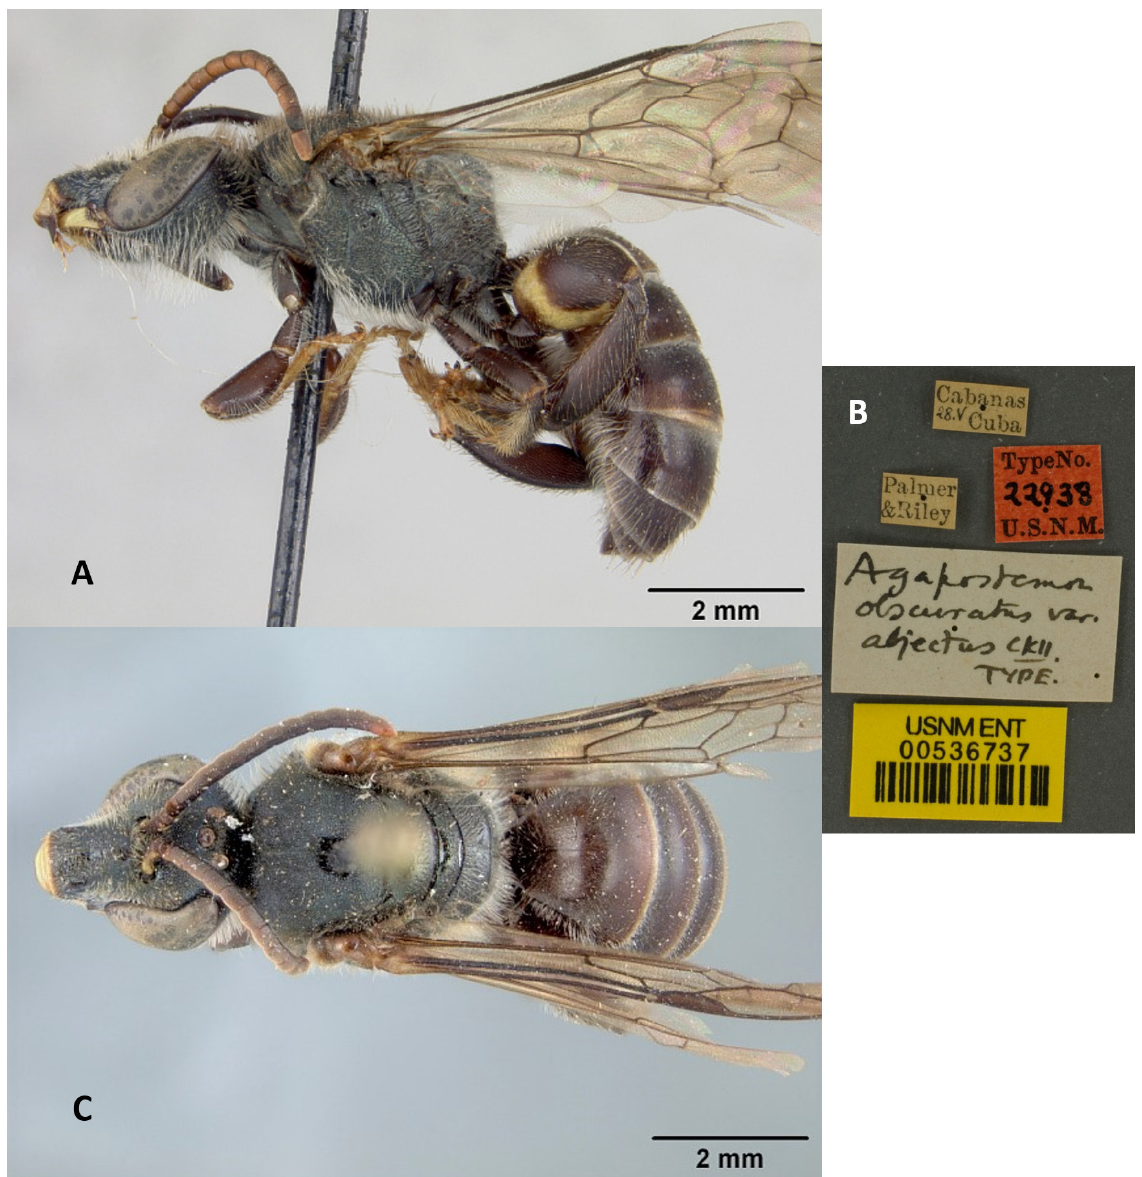
Fig. 6. Agapostemon obscuratus var. abjectus Cockerell, 1917. Holotype, ♂ (USNM 22938). A . Lateral view. B . Associated labels. C . Dorsal view. Photos by